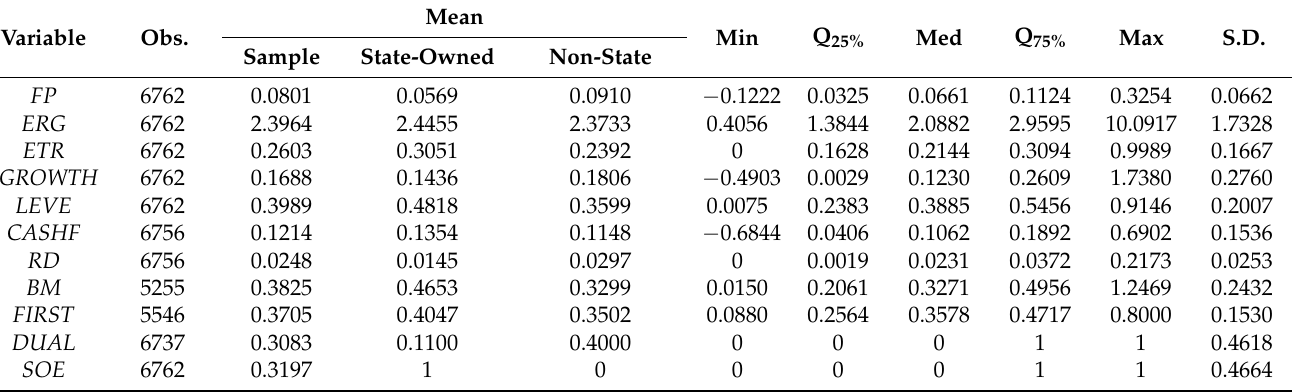
Table 2. Descriptive statistical